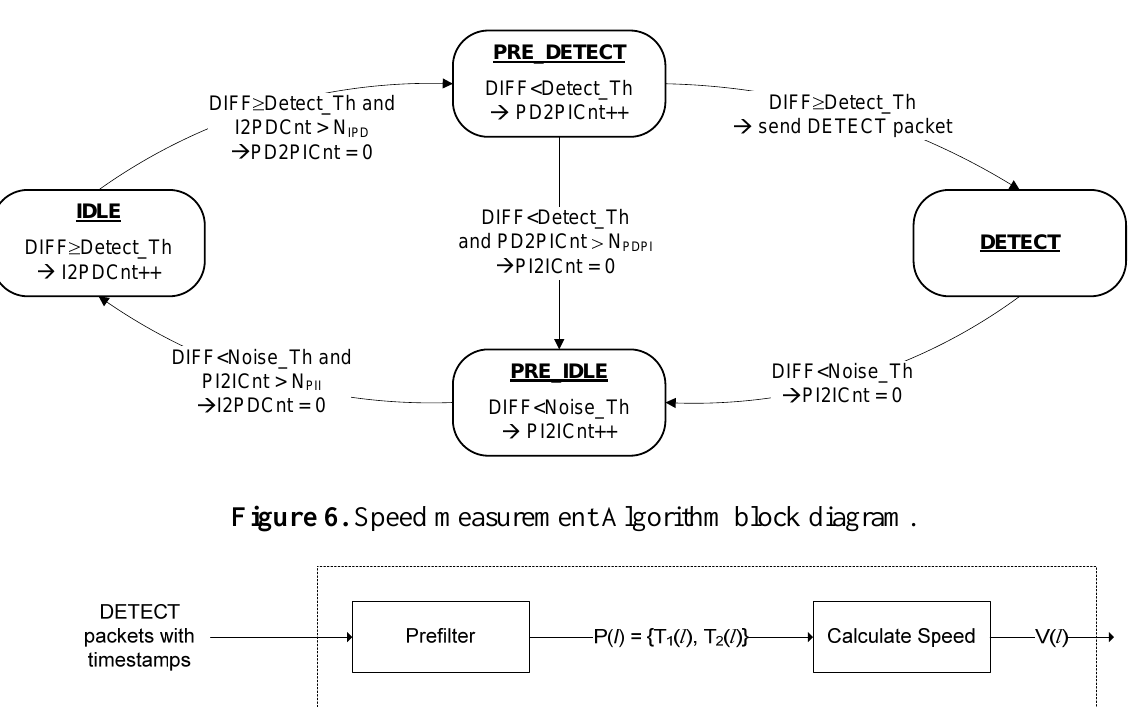
Figure 5. State Diagram for the decision block.